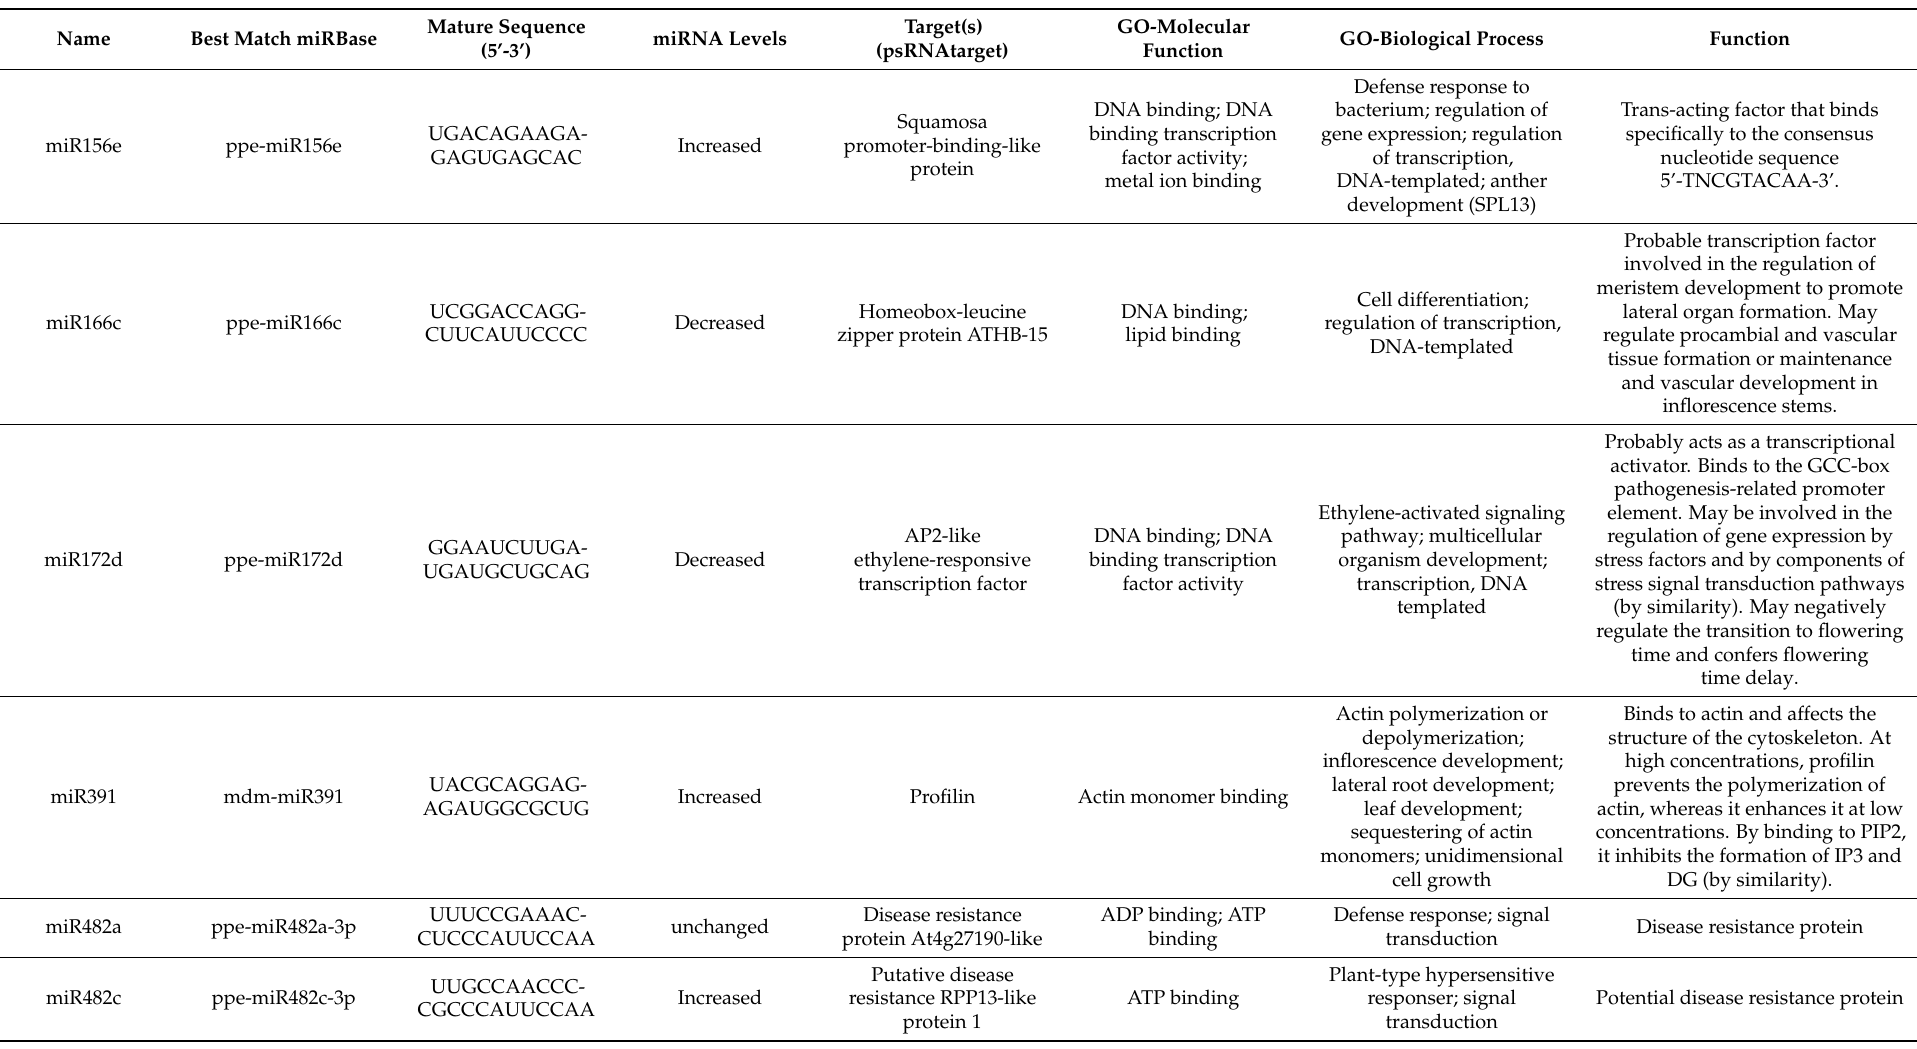
Table 2. Summary of notation and characterization of Prunus avium miRNAs and their targets